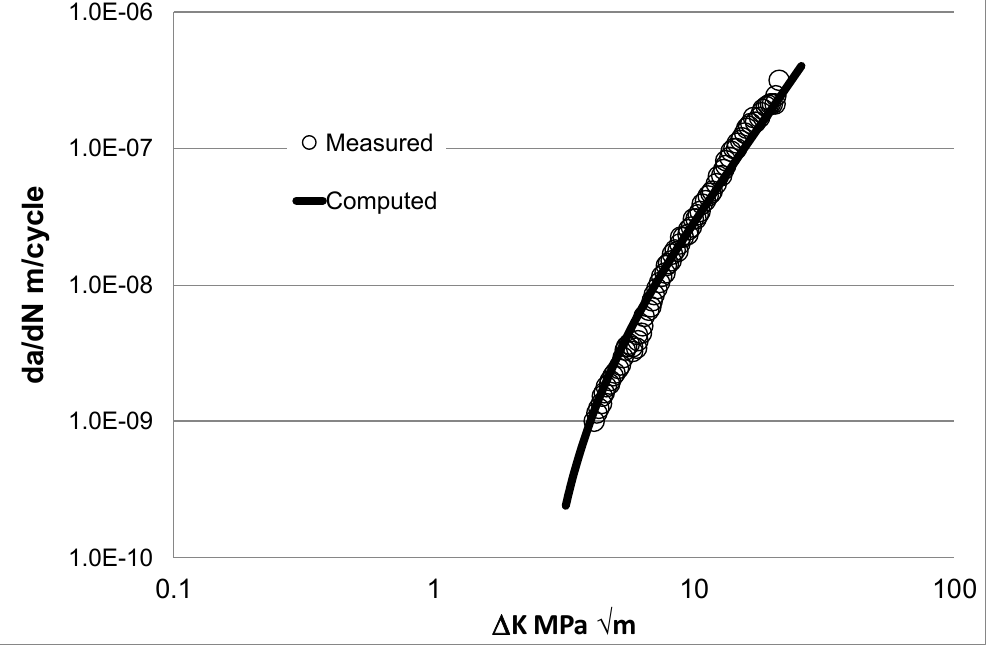
Figure 3. Comparison between the measured [72] and computed da/dN versus ∆ K curve for the baseline material.